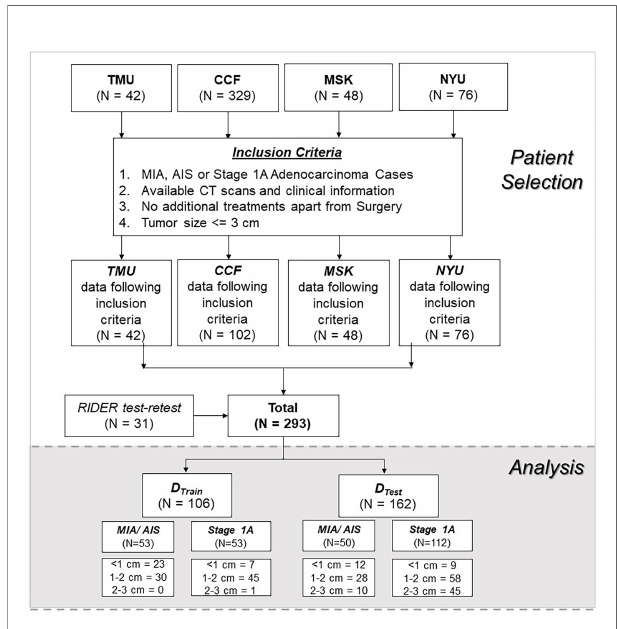
FIGURE 2 | Data source and CONSORT diagram for patient